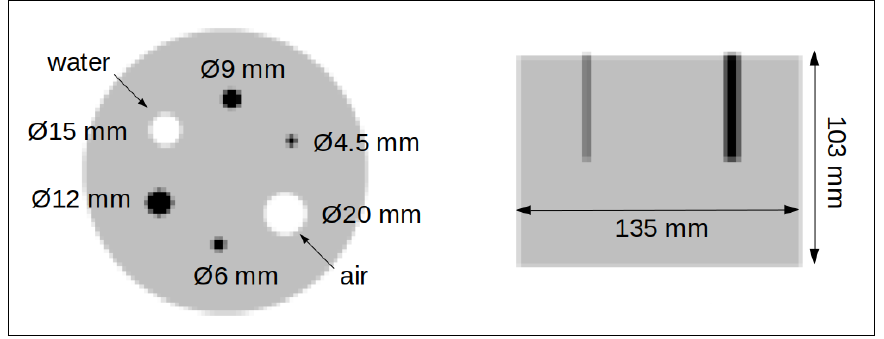
Figure 3. Geometry of the image quality phantom [11]. The phantom and four smaller rods were filled with 18 F water. One rod was filled with non-radioactive water, and the biggest rod was left empty. The hot rod to background activity concentration equals